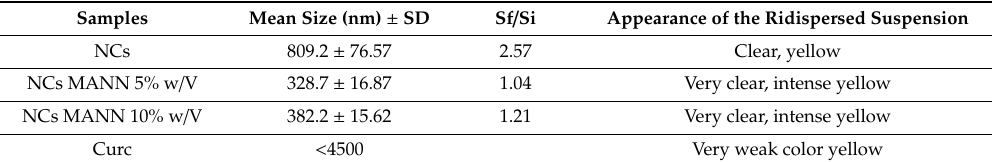
Figure 3. Mean size and polydispersity index (PDI) of NCs before and after freeze-drying without and with mannitol as cryoprotectant. BF = before freeze-drying; AF = after freeze-drying; 5% Mann = 5% (w / V) mannitol; 10% Mann = 10% (w / V) mannitol. Tukey’s test for NC size and PDI. The * symbol denotes statistical significance di ff erence for size; The # symbol denotes statistical significance di ff erence for PDI. Significance was defined as **** p < 0.0001. Table 3. Lyophilization results of NCs with and without cryoprotectant.